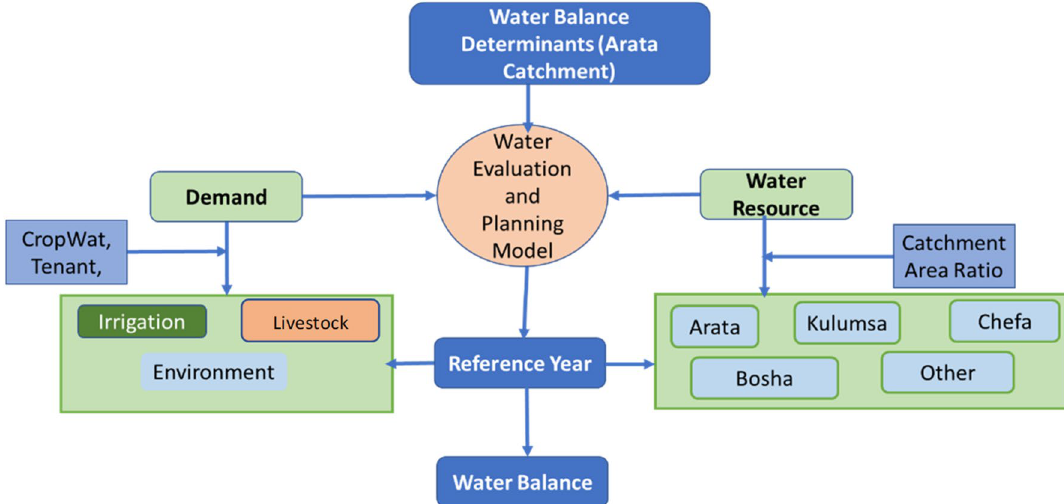
Fig. 3 Arata catchment water balance analysis